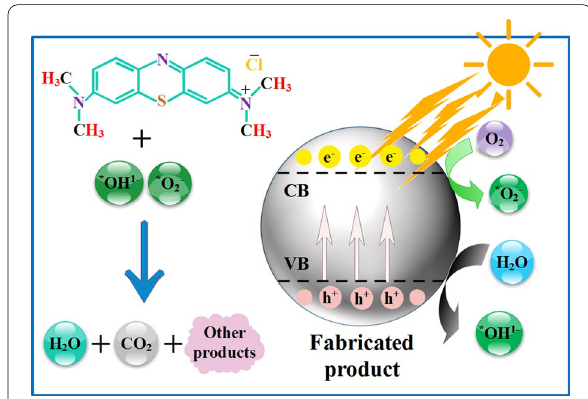
Fig. 3 Illustration of degradation of methylene blue MB by